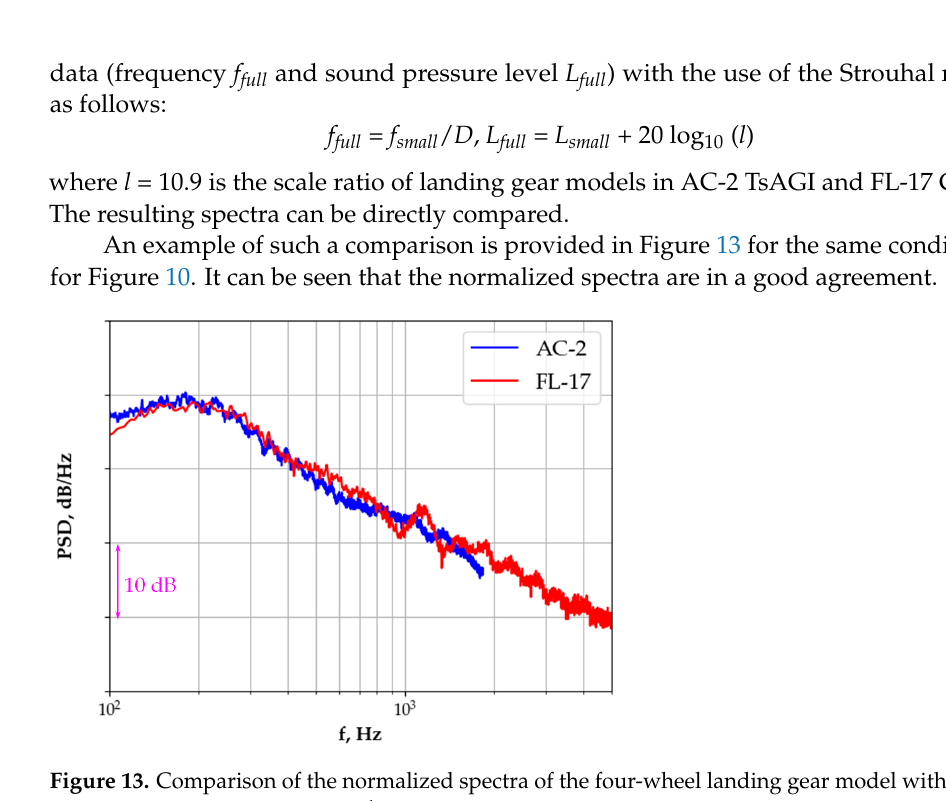
( b ) Figure 12. Interpolation of noise levels measured in AC-2 TsAGI to azimuthal angles θ 0 , corre- sponding to FL-17 CARDC for ( a ) 2000 Hz, ( b ) 12,000 Hz. 4.6. Strouhal Scaling (for AC-2 TsAGI Data) The resulting noise spectra correspond to landing gear noise measured for small-scale and large-scale models in the same conditions. Then, the AC-2 TsAGI data are transferred to the full scale, thus allowing the results from the two facilities to be directly